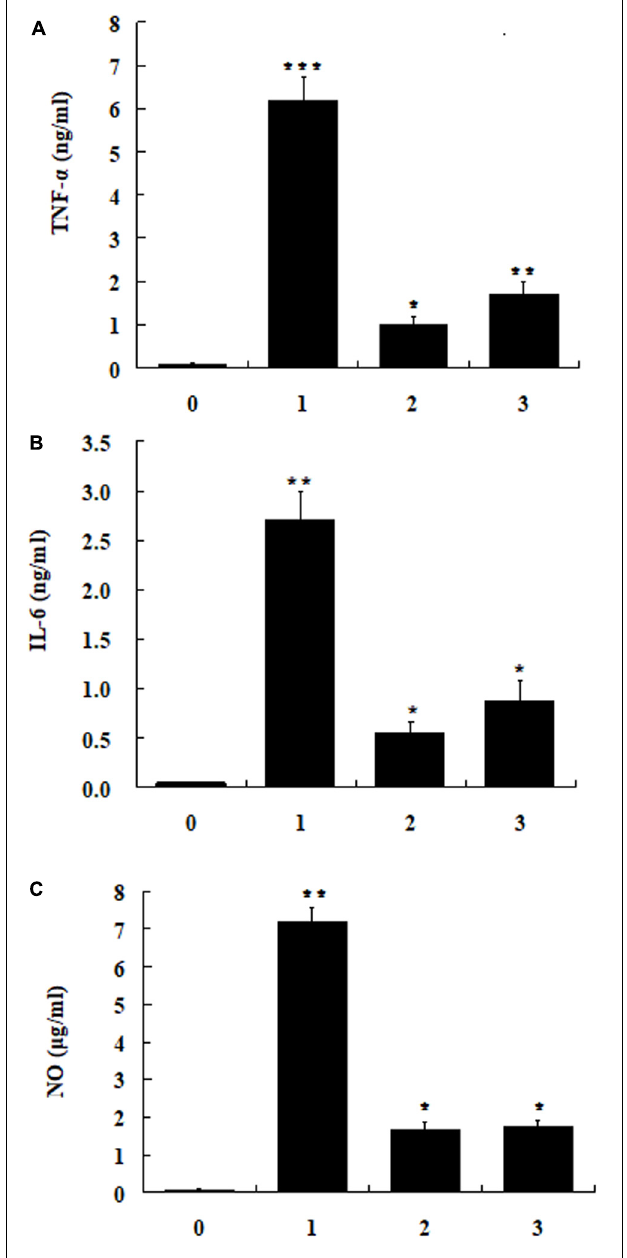
FIGURE 7 | The RAW264.7cells were treated with LPS (200 ng/ml) and the peptide dCATH(1–16) or dCATH(5–20) at the concentrations of 32 µ M for 24 h. TNF- α (A) and IL-6 (B) production was measured with an ELISA method. NO (C) production was assayed using Griess reagent. (0), (1), (2), and (3) were control, LPS treated, LPS + dCATH(1–16) treated and LPS + dCATH(5–20) treated, respectively. All bar graphs represent the mean ± SEM of three independent experiments. Means in the same concentration with different superscript are very significant difference ( P <